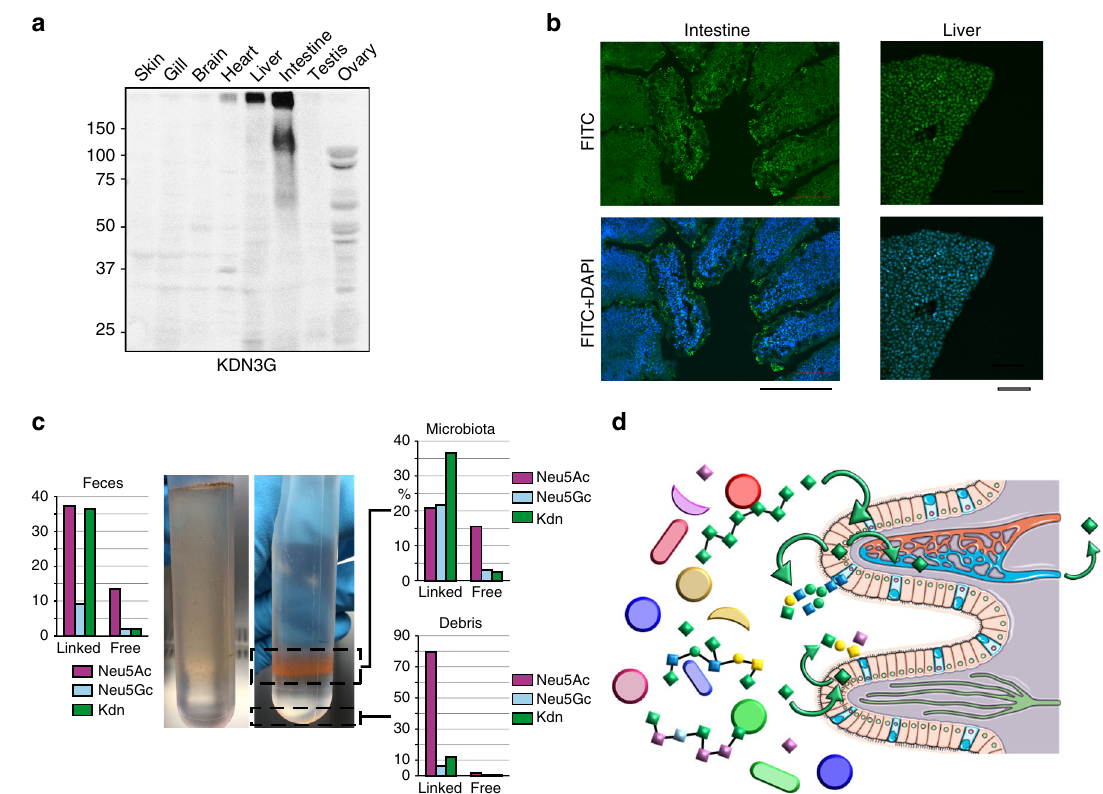
Fig. 8 Distribution of Kdn in organs. a WB screening of organs using Kdn( α 2,3)Gal speci fi c-epitope KDN3G antibody raised against GM3-Kdn and characterized to recognize a puri fi ed KDN-containing glycoprotein (Gp-Kdn) derived from rainbow trout ovarian fl uid 11,76 . Control experiments using IgM/G are shown in Supplementary Figure 9b. b Histochemistry staining using DAPI and KDN3G showed the presence of Kdn( α 2,3)Gal at the surface of intestine epithelium and liver cells. Scale bar corresponds to 100 μ m for intestine and 50 μ m for liver. Control experiments using IgG are shown in Supplementary Figure 10. c Sialic acid composition analysis of feces before (left panel) and after (right panel) puri fi cation of by Nycodenz ® gradient centrifugation shows a preferential association of Kdn with glycoconjugates of microbiota. d Hypothesized recycling of bacteria associated Kdn (green diamonds) by epithelial cells into endogenous glycoconjugates and subsequent transfer into blood